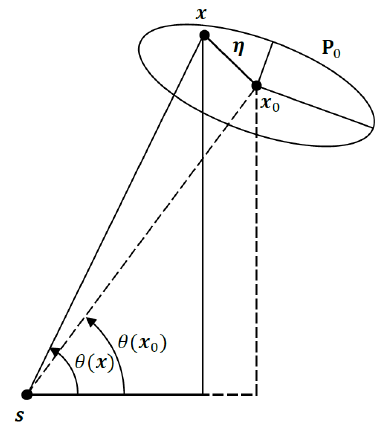
Figure 2. Geometric interpretation of instantaneous angle